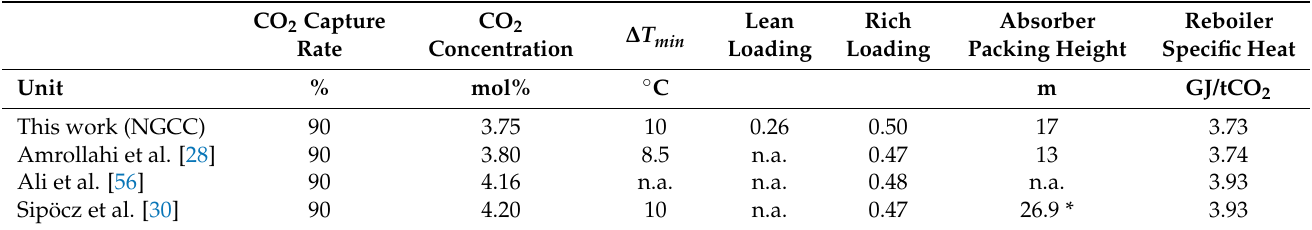
Table 5. Comparison of NGCC power plant’s exhaust gas process simulation results with literature.